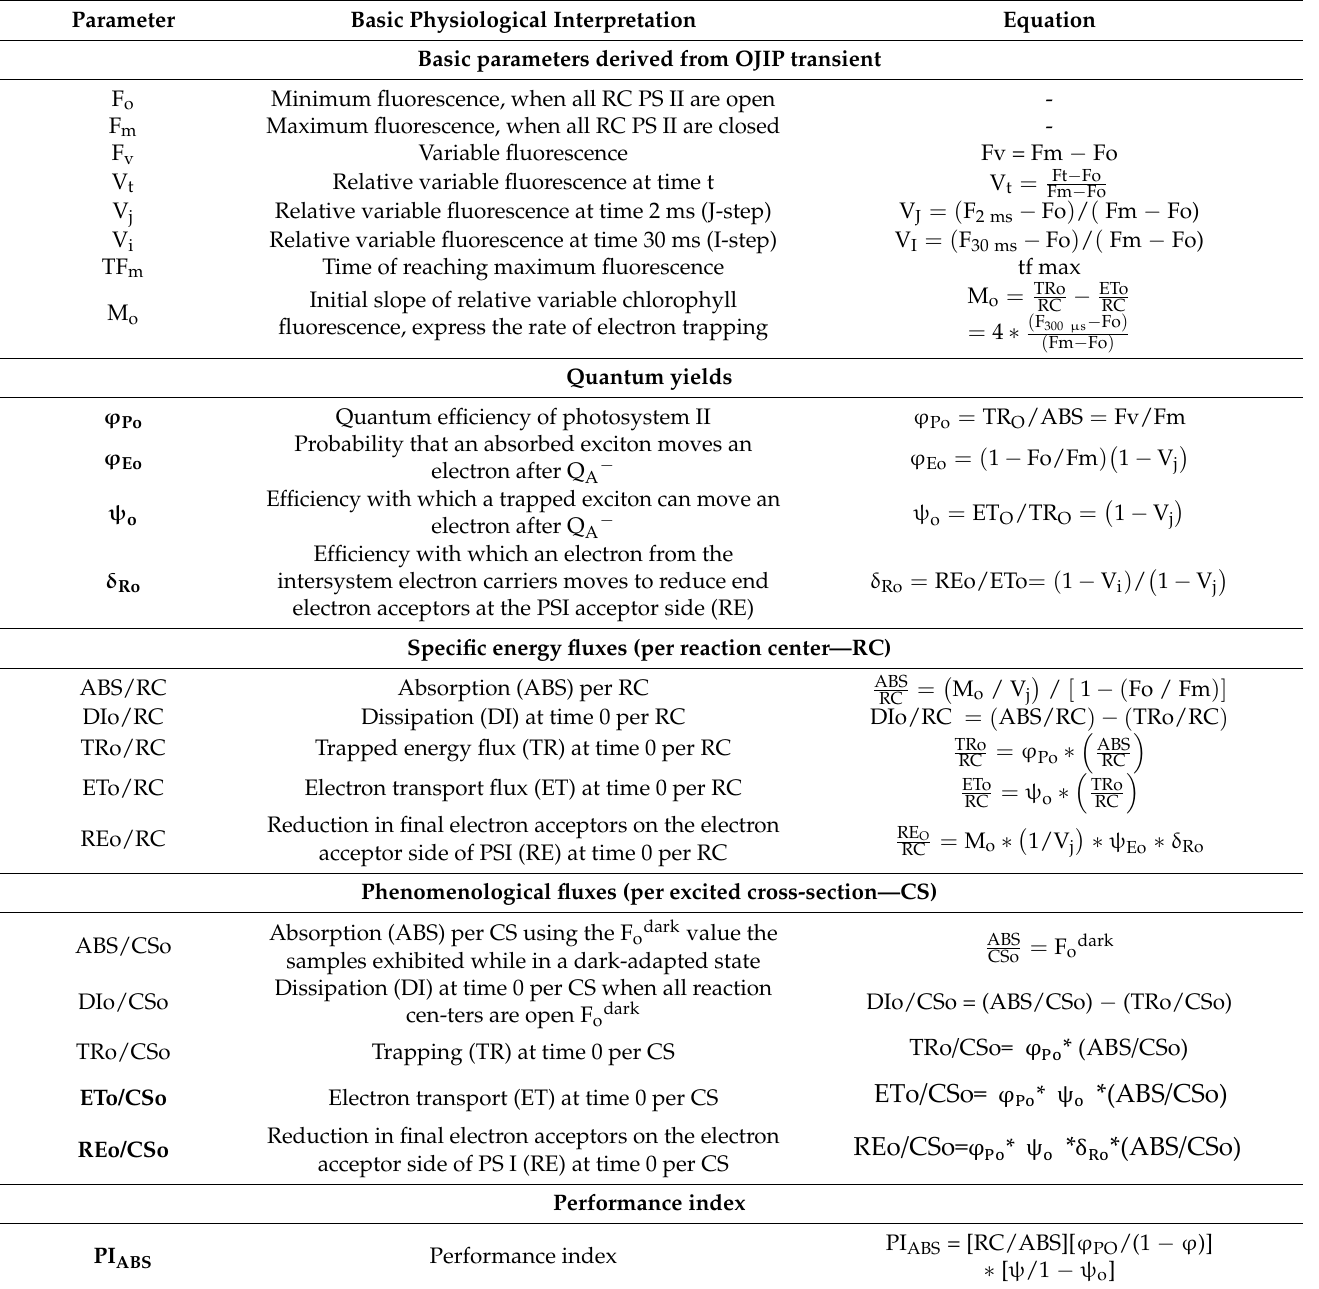
Table 4. Formulae and glossary of chlorophyll fluorescence parameters derived from OJIP test, as de- scribed by Brestic and Zivcak [97], Gururani et al. [98], Strasser et al. [30] and Gonz á lez Moreno